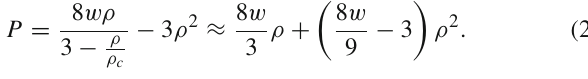
Fig. 1 Graph for internal energy w = − 2